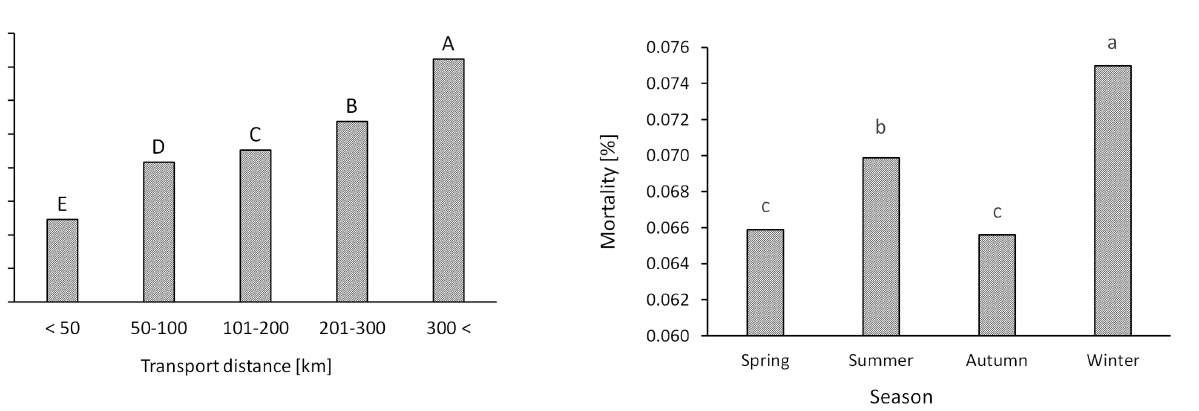
Figure 1. Transport-related mortality of finisher pigs as affected by transport distance. A-E Mortality in columns with different superscripts differ significantly (p<0.001).